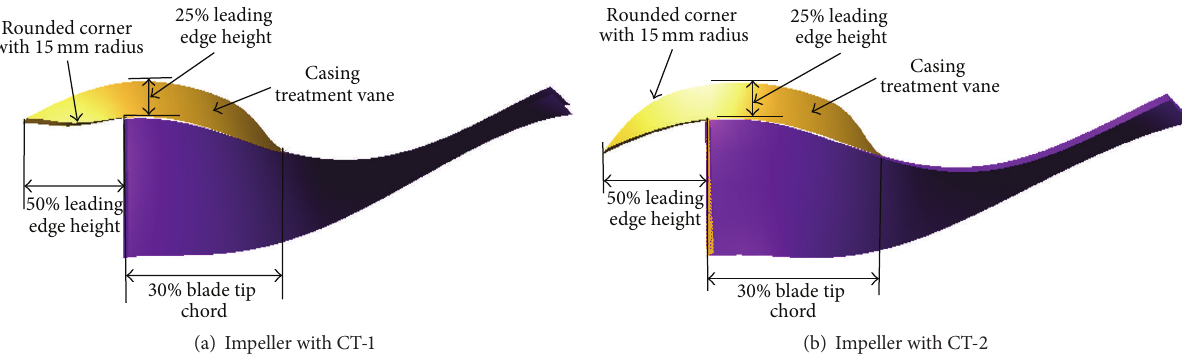
Figure 4: CAD models of single impeller blade with CT-1 and CT-2, highlighting the position and proportions of casing treatment vane/slot. (For impeller with CT-3, the upstream length is 100% of leading edge